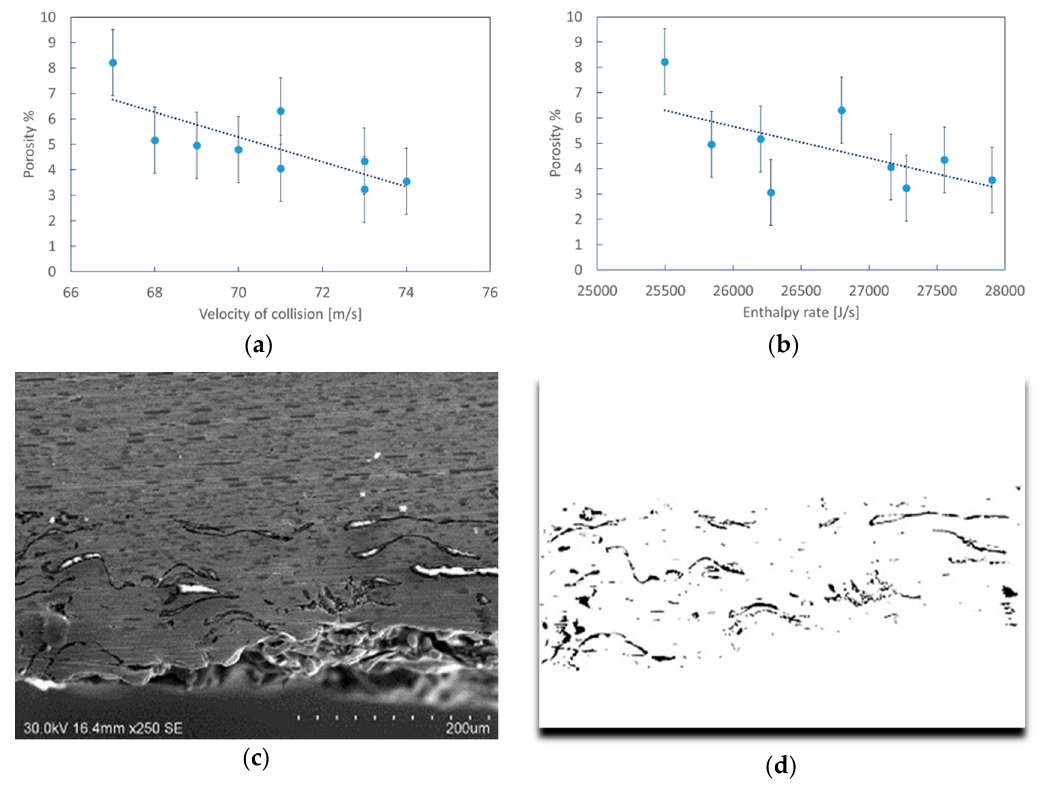
Figure 7. ( a ) Porosity percentage vs. collision velocity of the particles; ( b ) porosity percentage vs. enthalpy; ( c ) and ( d ) SEM micrography processing by gray contrast